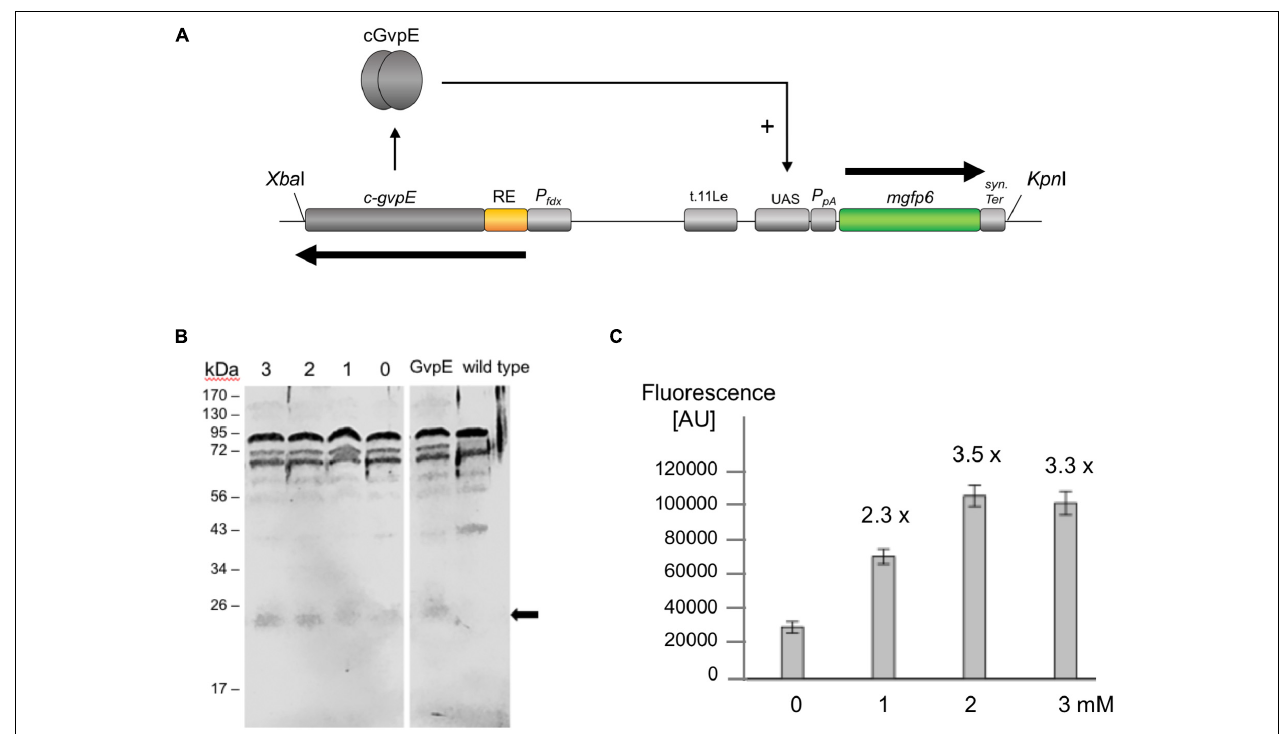
FIGURE 5 | GvpE-mediated activation of P pA under control of riboswitch E. (A) Genetic map of the Xba I- Kpn I fragment containing the relevant genes and regulatory structures of plasmid pPAJB20. The c- gvpE gene of the c-vac region of Hbt. salinarum is placed under control of P fdx and riboswitch E (RE, yellow), and in the opposite orientation the reporter gene mgfp6 is placed under control of P pA including the UAS A sequence required for GvpE-mediated activation of P pA . The mgfp6 gene is surrounded by the two terminator sequences t.11Le and synTer to prevent read-through. Arrows depict the direction of transcription. (B) Western blot analysis to detect the amounts of GvpE in cells grown in the presence or absence of theophylline. Cells were grown to OD 600 1.2 and disrupted to isolate total proteins. Twenty µ g of total protein each were separated by SDS-PAGE and transferred to a PVDF membrane. The detection of GvpE was done using a GvpE antiserum and a second antibody coupled with the fluorescent dye IRDye 800 CW (LI-COR). Western blots were inverted to black and white. The expected protein size of GvpE is indicated by an arrow. Numbers on the left are marker sizes in kDa. The numbers 1, 2, and 3 depict theophylline concentrations in mM; 0, without theophylline. GvpE, total protein of a GvpE-producing transformant, wild type, total proteins of Hfx. volcanii WR340. (C) P pA activation in pPAJB20 transformants producing different amounts of GvpE. The pPAJB20 transformants were incubated with 0, 1, 2, or 3 mM theophylline in 3 M salt media at 37 ◦ C. The fluorescence of the cells was measured after 30 h of growth (OD 600 of 0.6) and is given in arbitrary units (AU) ( Supplementary Table 5 ). The experiments were performed in triplicates on three different days. 0, 1, 2, 3 mM designate the respective theophylline concentrations used. TABLE 1 | Putative SD sequence in riboswitches A through E and E*.